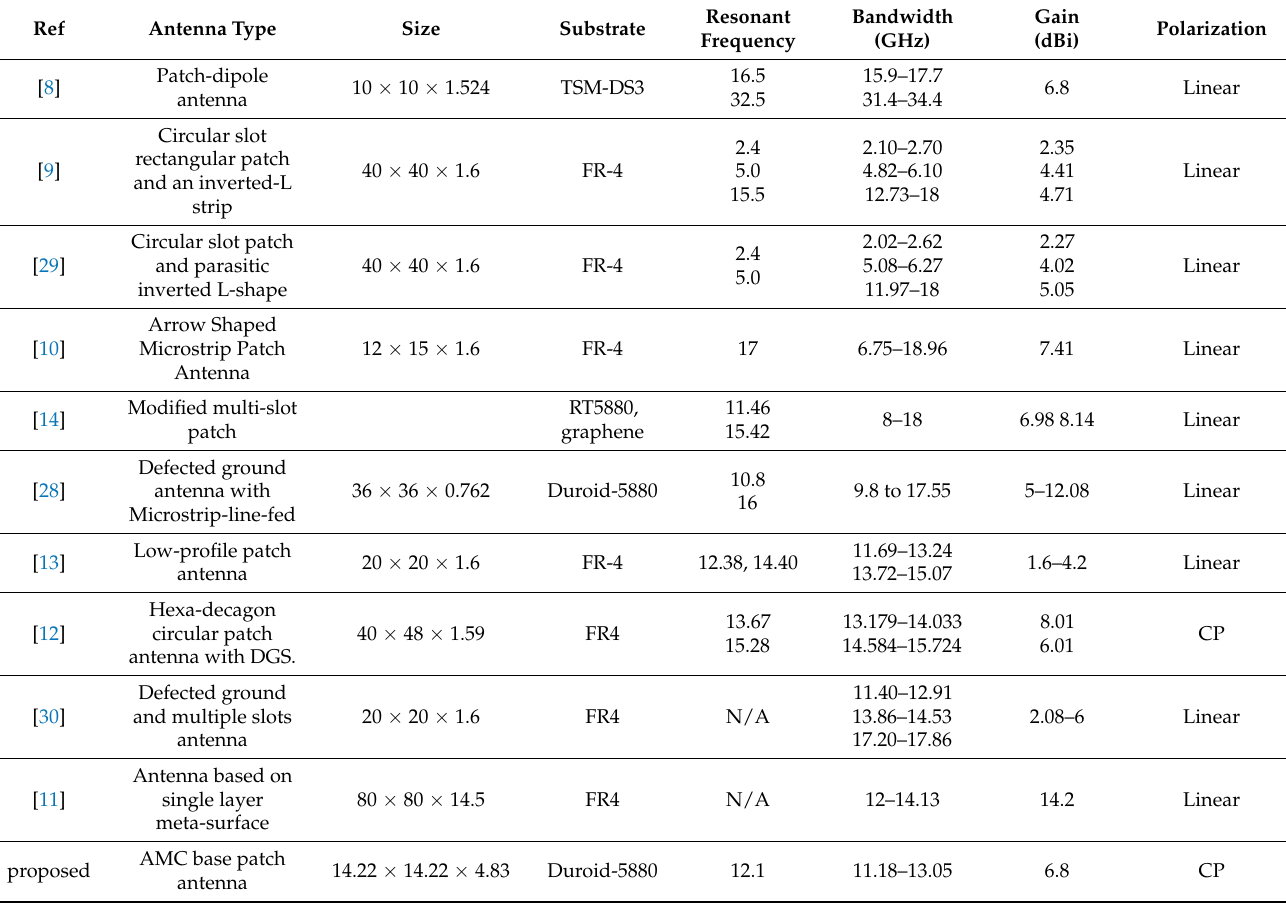
Table 2. Comparison with the existing